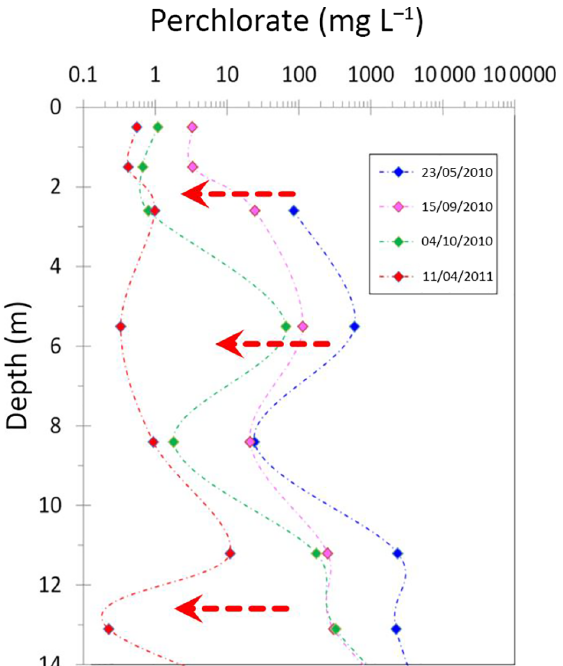
Figure 5. Perchlorate concentration profile across the entire vadose zone and top groundwater under the pilot site during the infiltra- tion experiments. The profiles emphasize the gradual increase in perchlorate concentration with time (marked in red arrows). Dates are given as day/month/year. Note that data points are aligned in a slanted orientation and interpolated as time